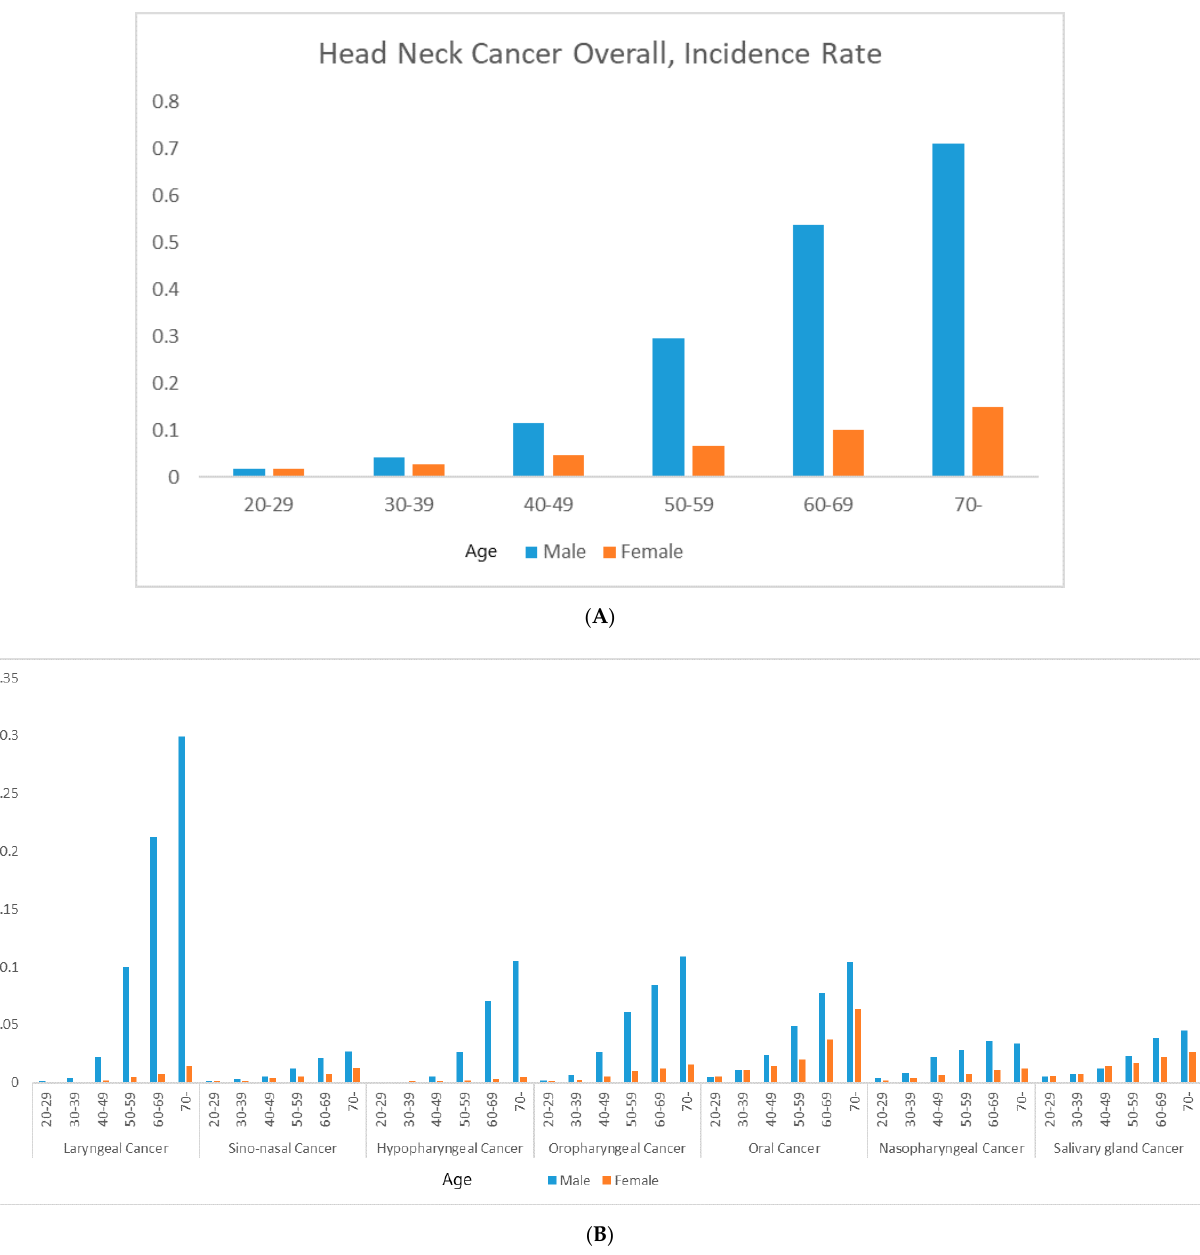
Figure 3. The incidence of head and neck cancers in healthy men and women by age during the 10-year follow-up period. ( A ) All head and neck cancers and ( B ) cancers by the subsites.